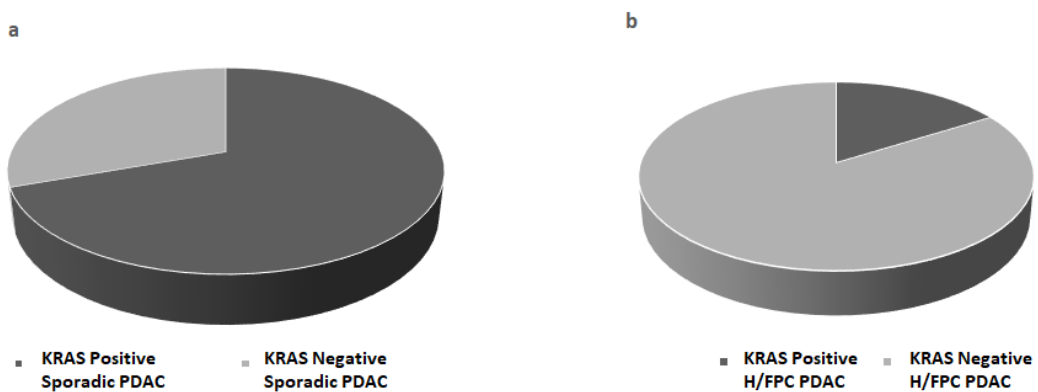
Figure 2. KRAS mutation status was determined in plasma from ( a ) sporadic PDAC cases ( b ) hereditary or familial PDAC (H/FPC) cases via BEAMing and mutant KRAS was more frequently detected in sporadic cases compared to H/FPC cases. BEAMing was performed using cfDNA isolated from 1 mL of plasma from 54 PDAC cases (31 familial cases and 23 sporadic cases). The frequency of mutant KRAS was 70% in sporadic cases and 16% in familial cases, which was statistically significant ( p ≤ 0.001).